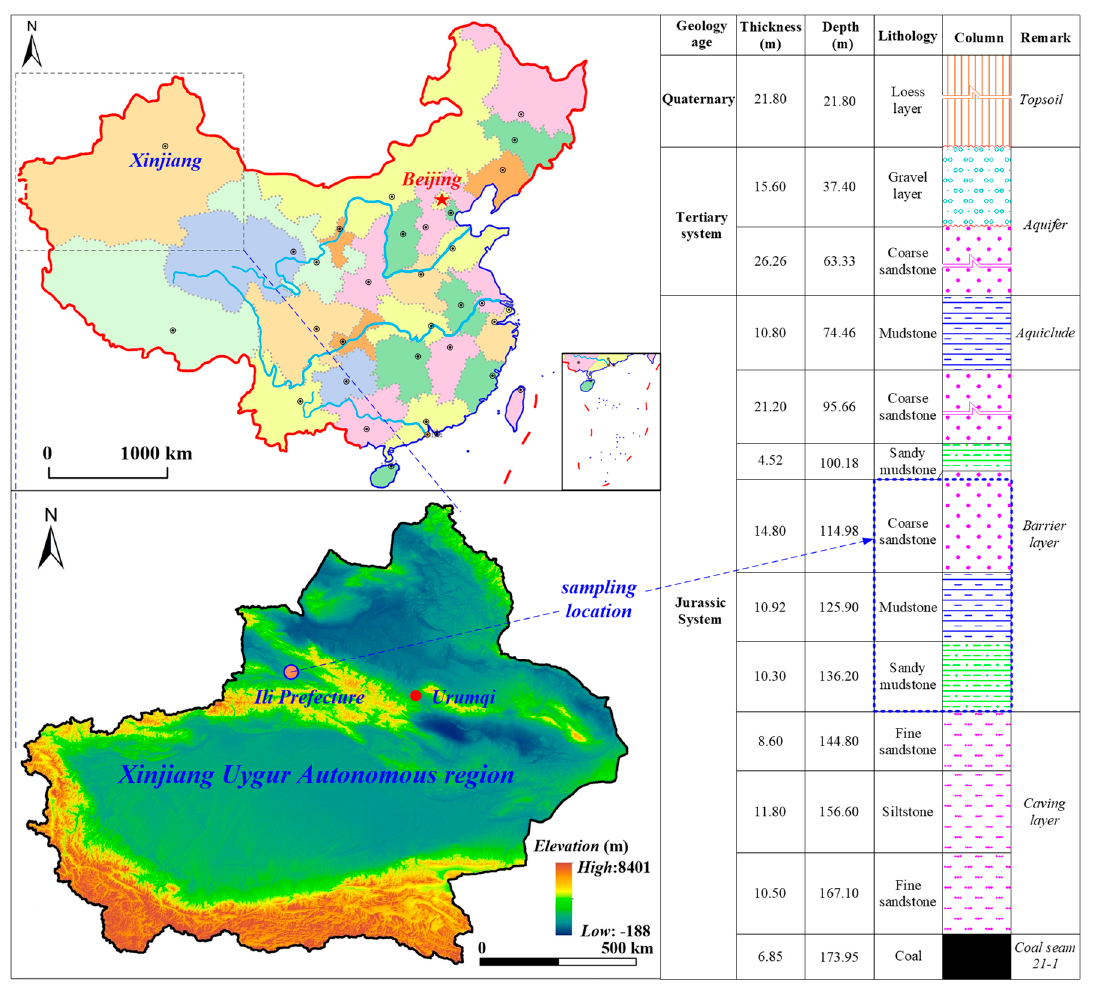
Figure 2. Location and general geological stratigraphy of the weakly cemented strata.